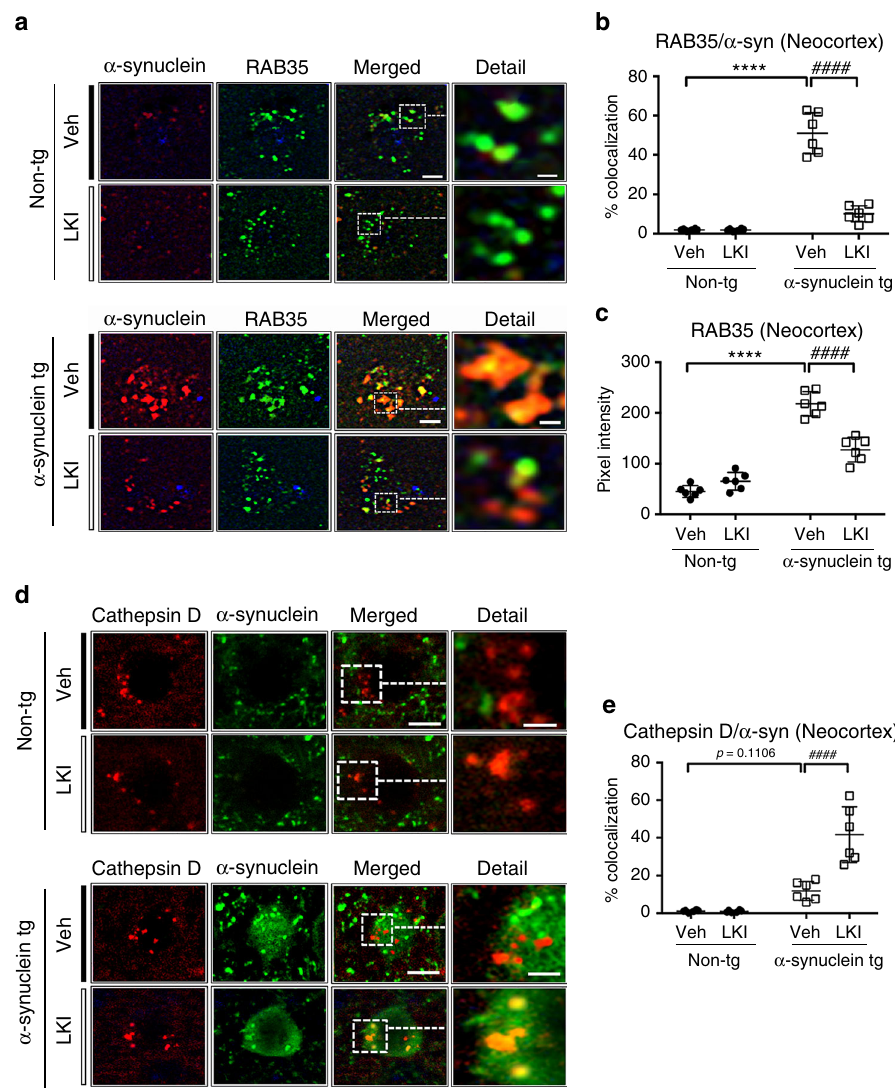
Fig. 9 Blockade of LRRK2 kinase regulates traffkicking of α – synuclein in mice. a Non-tg and α -syn tg mice were treated with either vehicle or LRRK2 inhibitor for 4 weeks. Brain sections were double-immunolabelled with antibodies against α -synuclein and RAB35. Scale bars, 25 μ m. b Co-localization analysis of α -synuclein and RAB35 in neocortex of non-tg and α -syn-tg mice. Treatment F(1,20) = 79.8, Genotype F(1,20) = 156, Interaction F(1,20) = 79.15, **** p < 0.001, #### p < 0.001. c Fluorescence intensity analysis for RAB35 in neocortex of non-tg and α -syn tg mice. Treatment F(1,20) = 18.58, Genotype F(1,20) = 208.1, Interaction F(1,20) = 46.07, **** p < 0.001, #### p < 0.001. d Non-tg and α -syn tg mice were administrated with either vehicle or LRRK2 inhibitor for 4 weeks. Brain sections were double-immunolabelled with antibodies against α -synuclein and Cathepsin-D. Scale bars, 25 μ m. e Co- localization analysis of α -synuclein and Cathepsin D in neocortex of non-tg and α -syn-tg mice. Treatment F(1,20) = 21.55, Genotype F(1,20) = 65.25, Interaction F(1,20) = 22.01, #### p < 0.001. All data were analyzed by using two-way ANOVA with Tukey ’ s post hoc test. All analysis was done with N = 6 mice per group. Data are represented as mean ±